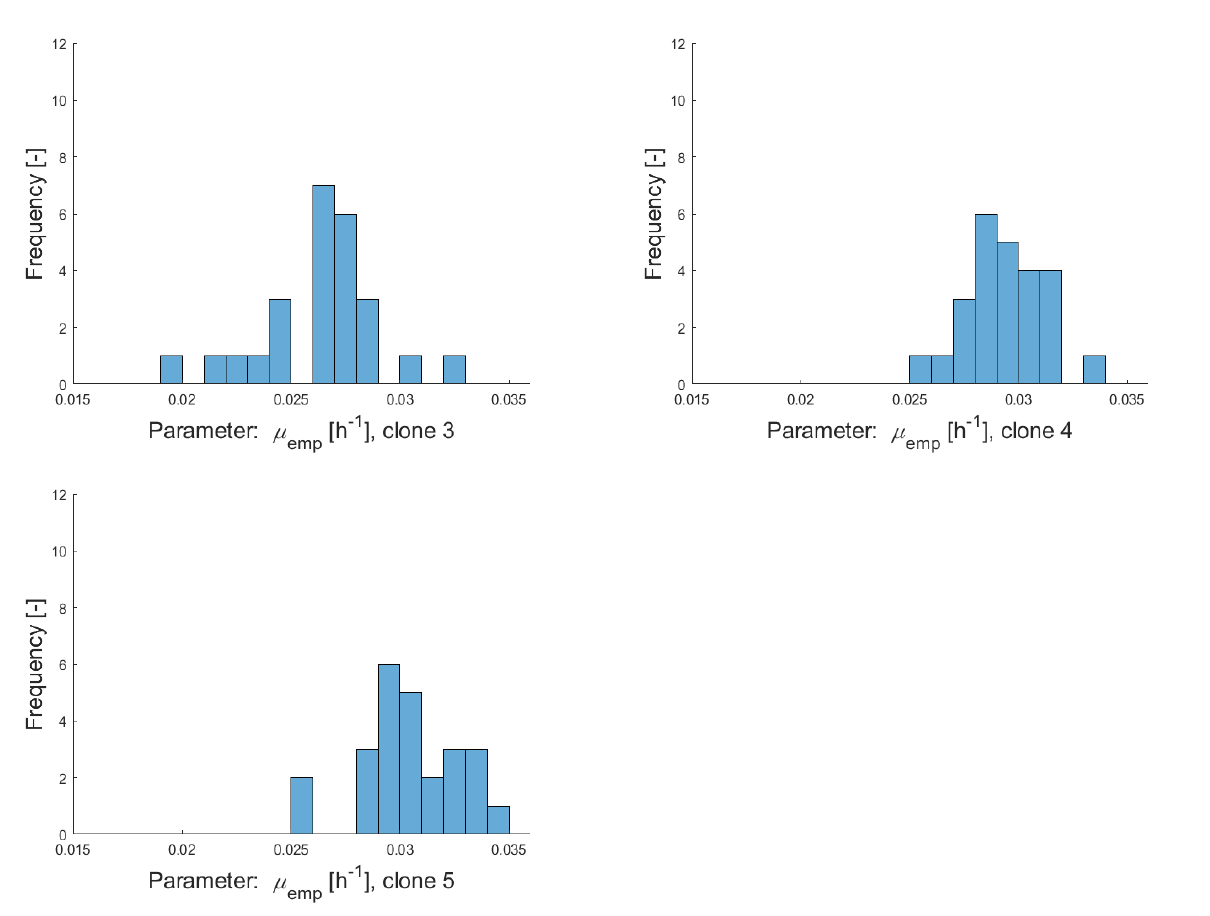
Figure A2. Histograms of empirical growth rates for clonal populations clone 1–clone 5 calculated over several subcultiva- tion steps with culture volumes of 5 mL (during a period of 13